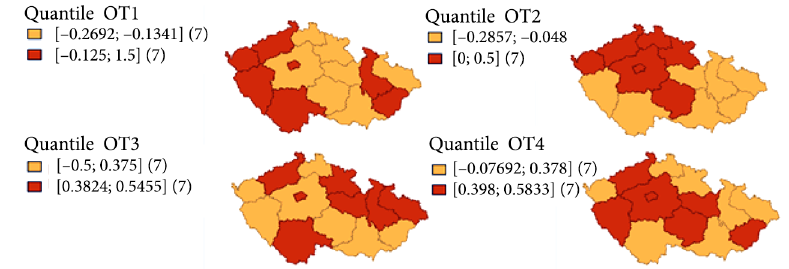
Figure 2. Results of spatial autocorrelation testing in case of Czechia (source: own processing) While the regions with concentrated state support are mostly located in the eastern part and near the borders in the northern part of the Czechia, these regions do not demonstrate the sings of the spatial autocorrelation in case of the questions 1 and 4. Figure 3 shows the map of Economically problematic regions (Ministry of Local Development of Czech Repub- lic,